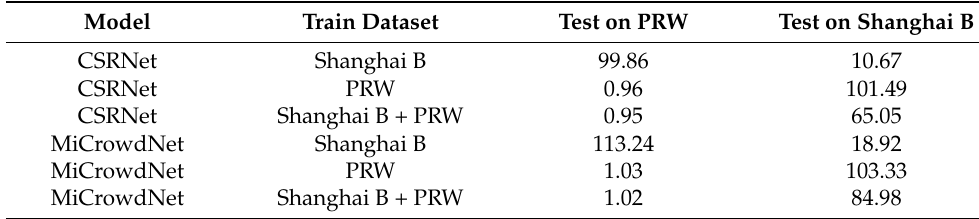
Table 4. Evaluation results (MAE) with various test and training datasets that show the impact of the domain